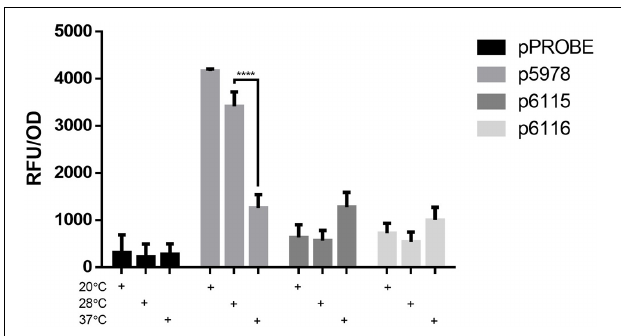
FIGURE 3 | Expression of the T6SS GFP reporter fusion strains (p5978, p6115, and p6116) and a control strain (pPROBE) in LB-NaCl at 180 rpm and 20, 28, or 37 ◦ C at the end of exponential phase. The means of biological triplicates are shown with error bars representing the standard deviation. A one-way ANOVA with Tukey’s multiple comparisons test was used to analyze the biological triplicate ( ∗∗∗∗ p ≤ 0.0001).